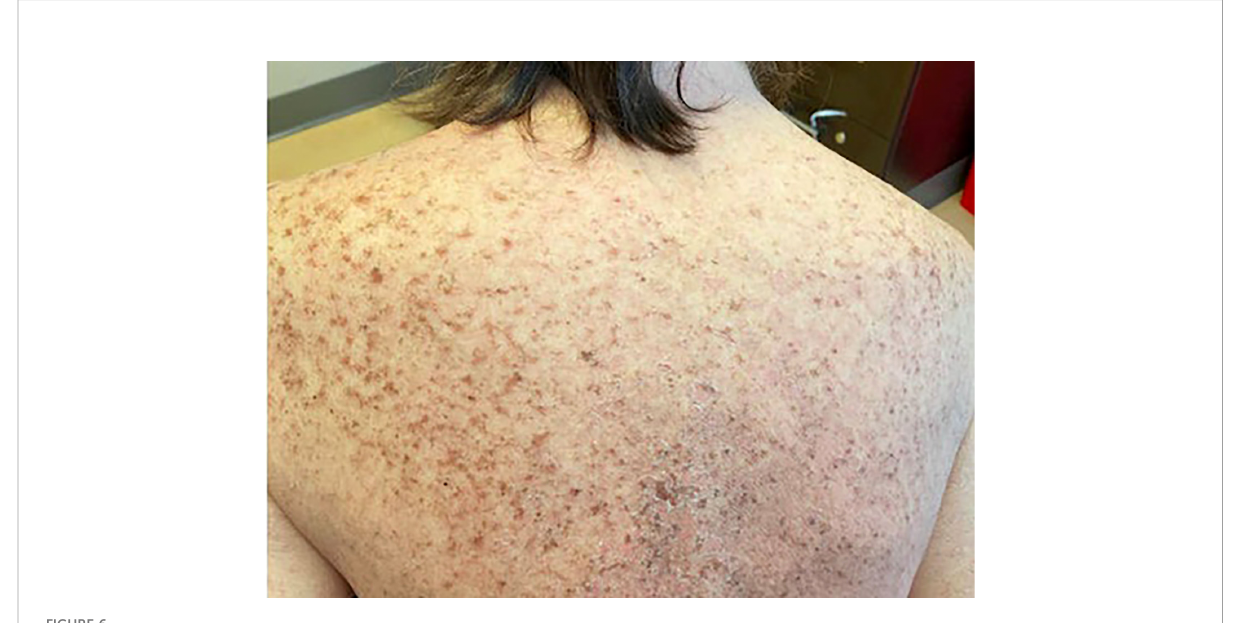
FIGURE 6 Patient ’ s back 11 days after initial